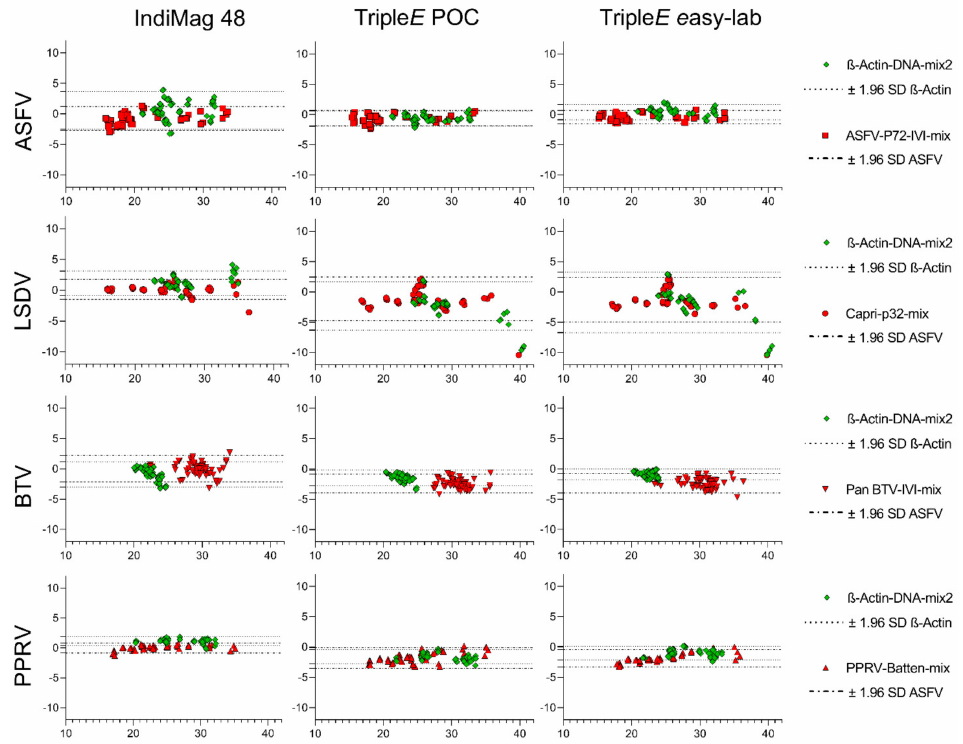
Figure 4. Evaluation of the analytical performance of the extraction methods. Bland-Altman plots comparing the KingFisher Flex automated method to the commercially available IndiMag 48 and the hand-made Triple E method. The dotted lines represent the limits (upper and lower) of agreement, for both the virus target (red) and the ß-actin (green). The plots show at the Y axis the differences between the Ct values obtained after real-time amplification for each of the evaluated viruses after KingFisher Flex extraction and at the X axis the tested systems against the average of the Ct values